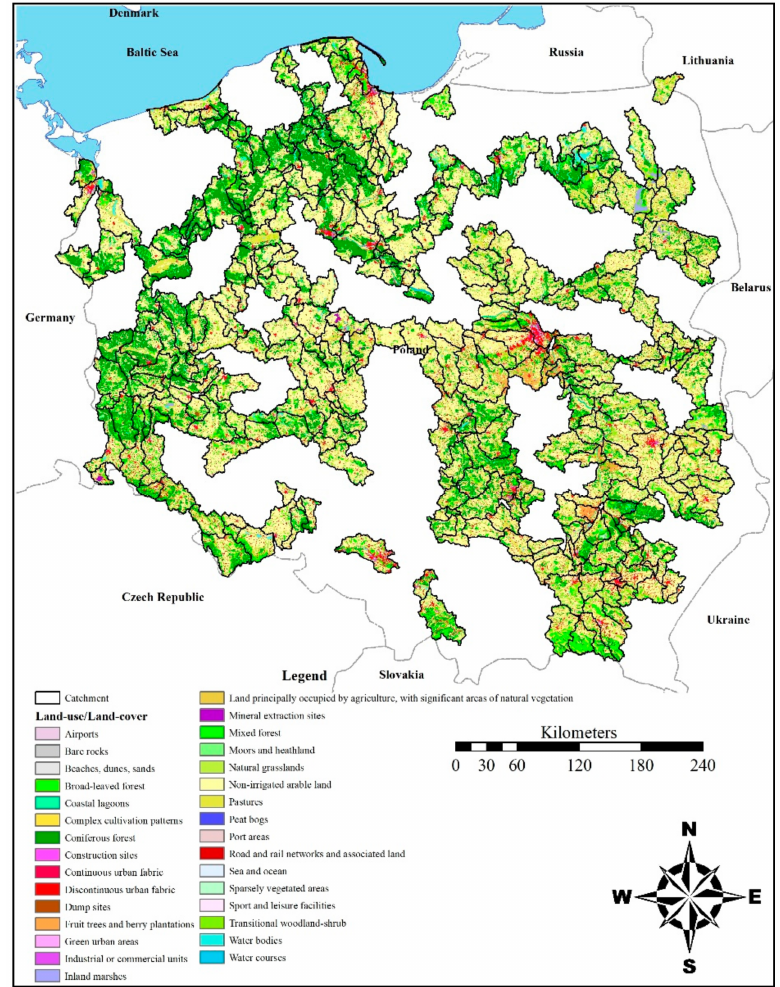
Figure 1. The geographical position of the study catchments and land use/land